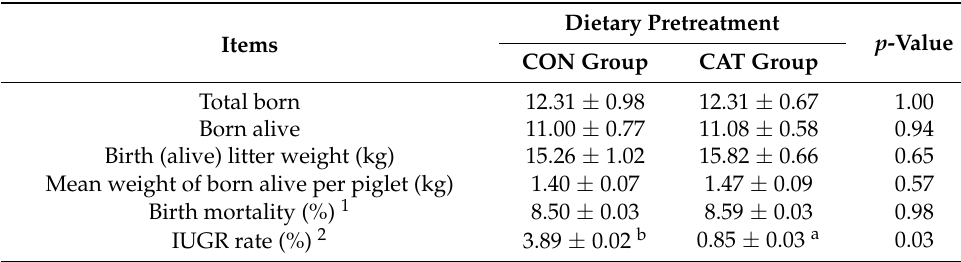
Table 3. Effects of maternal CAT supplementation during late pregnancy on the reproductive performance of sows.